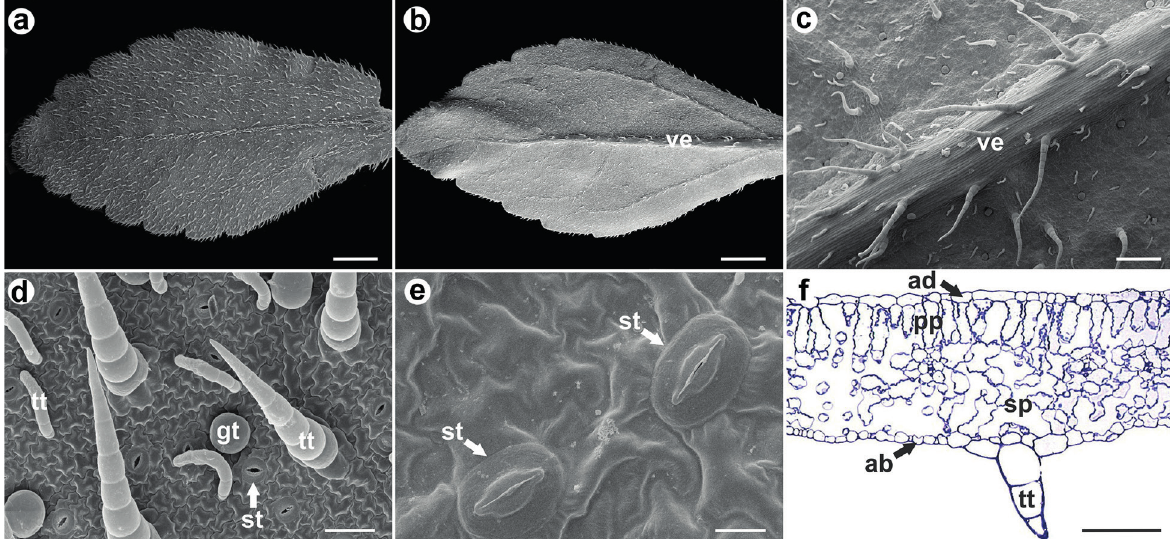
Figure 2 - Leaf morphology of Stevia rebaudiana (Asteraceae). a-e ) Morphology observed by scanning electron microscopy. f ) Anatomical aspects in light microscopy. a ) Leaf adaxial side; b ) Leaf abaxial side with prominent venation; c ) Detail of the venation on the abaxial leaf surface; d ) General view of the three types of trichomes on the abaxial surface; e ) Detail of anomocytic stomata. f ) Leaf cross section, showing details of the mesophyll and epidermis. ab: abaxial epidermis; ad: adaxial epidermis; gt: glandular trichomes; pp: palisade parenchyma; sp: spongy parenchyma; st: stomata; tt: tector trichomes; ve: venation. Bars: a = 0.5 cm; b = 100 μm; c = 1mm; d = 200 μm; e = 10 μm; f = 100